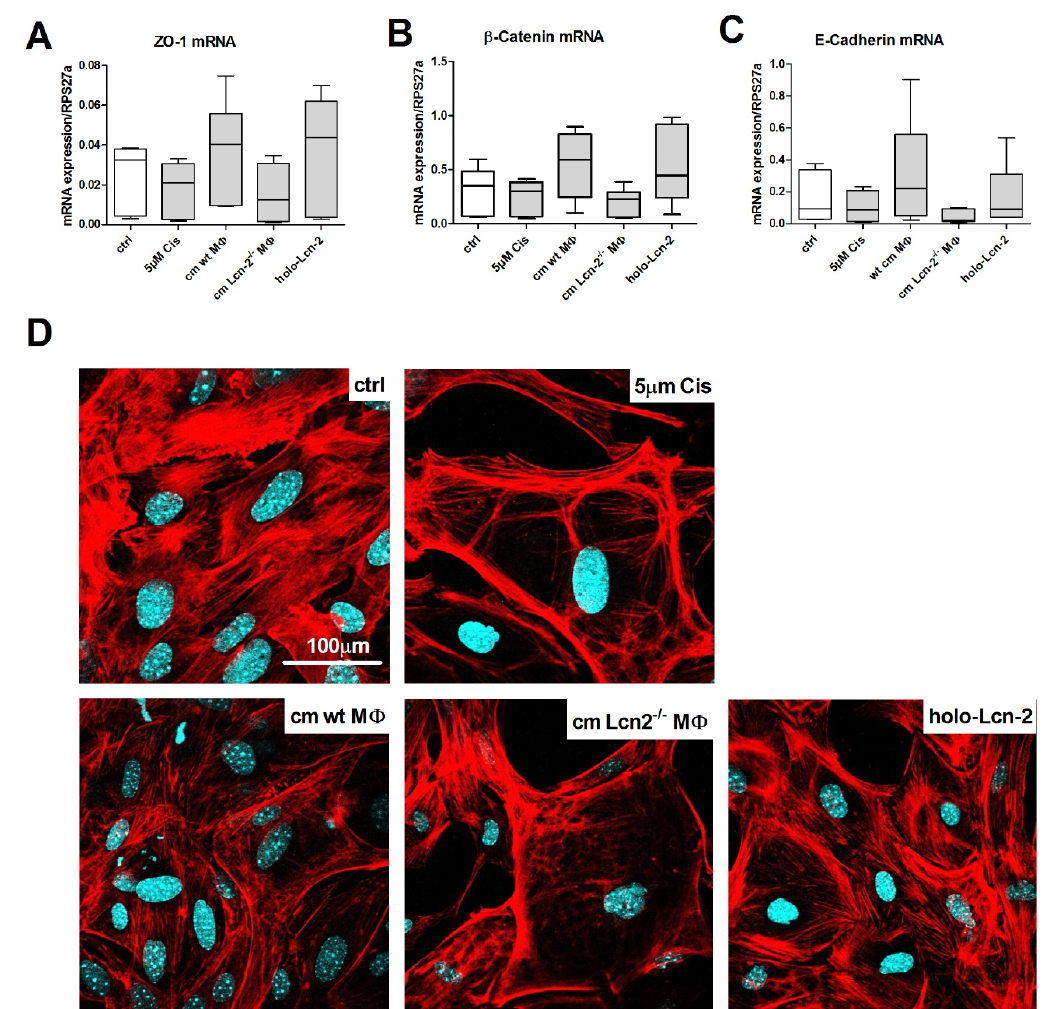
Figure 4. The epithelial phenotype is rescued by Lcn-2. mRNA expression relative to the housekeeping gene RPS27a of the epithelial phenotype markers ( A ) Zonula occludens-1 (ZO-1), ( B ) β -catenin, and ( C ) E-Cadherin (ns; n = 6). ( D ) Phalloidin staining visualizing the cytoskeleton and the F-actin stress fibers in red and nuclei in